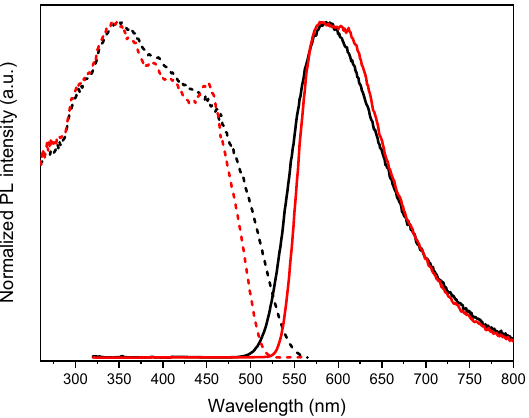
Figure 4. Normalized excitation (dashed) and emission (continuous) spectra of crystalline powders of 1 at 298 K (black, λ em = 588 nm; λ exc = 300 nm) and 77 K (red, λ em = 580 nm; λ exc = 300 nm).